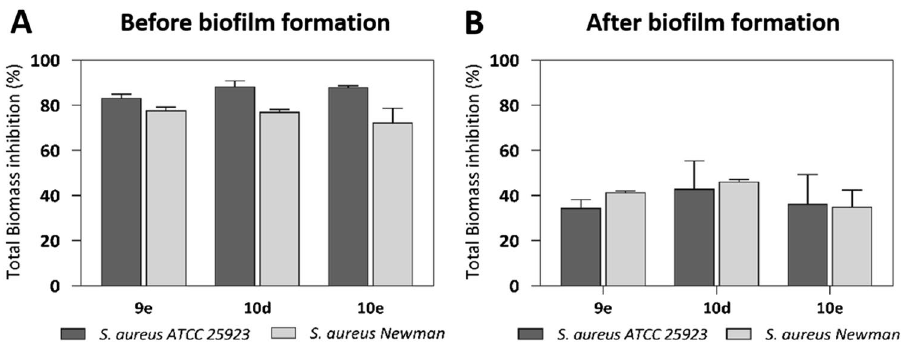
Figure 4. Anti-biofilm activities of 9e , 10d , and 10e at 100 µM in the pre- ( A ) and post-exposure ( B ) assays. The total biomass was quantified using the crystal violet staining. Data represent the mean of two independent repetitions with three technical replicates each ±